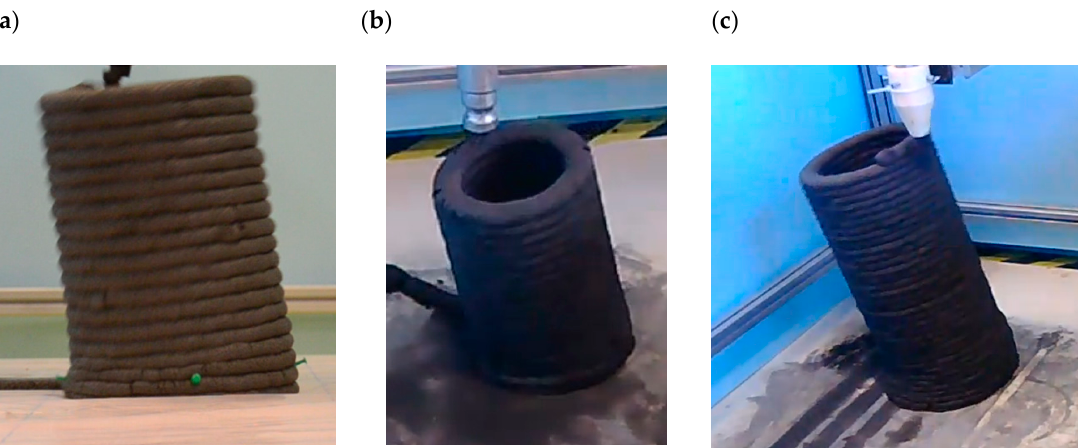
Figure 14. Collapse during printing for specimens of mix B840 / SF / FA / LP. ( a ) t b = 15 min; t p = 10 𝑠 ;